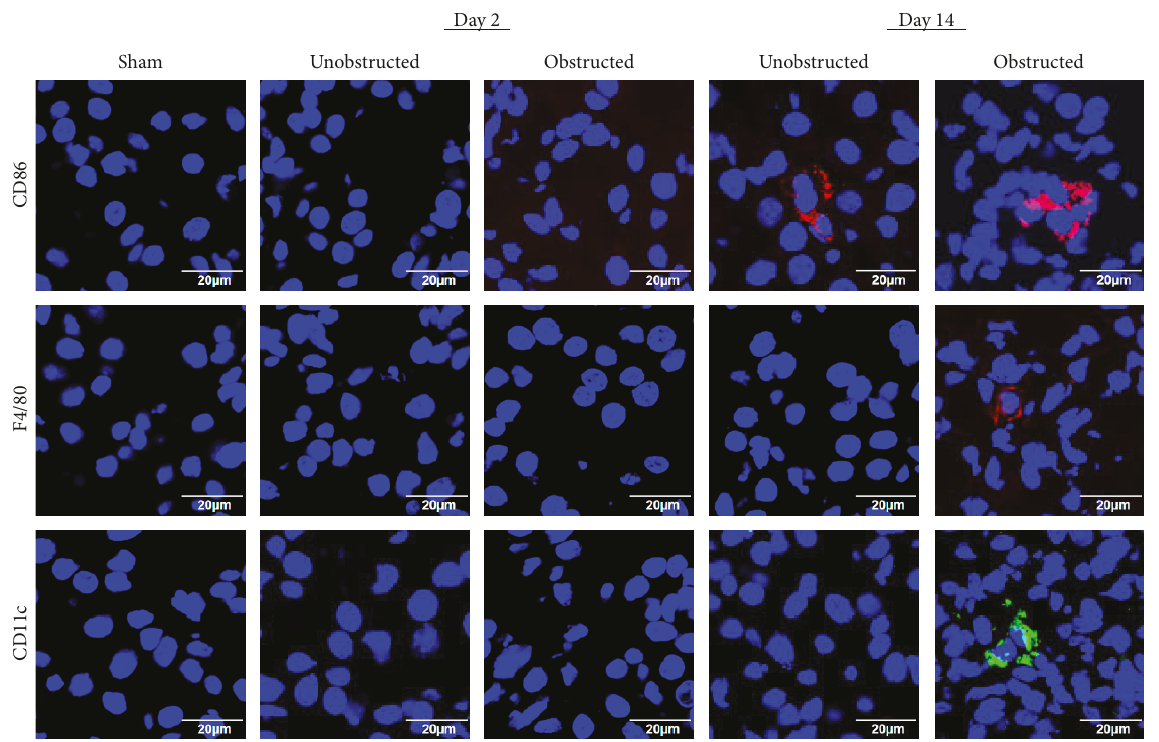
Figure 8: In fi ltration of in fl ammatory cells in renal tissues. Representative images of immuno fl uorescence staining with CD86, F4/80, and CD11c show the in fi ltration of in fl ammatory cells in renal tissues. Nuclei are counterstained with 4 ′ ,6-diamidino-2-phenylindole (DAPI,